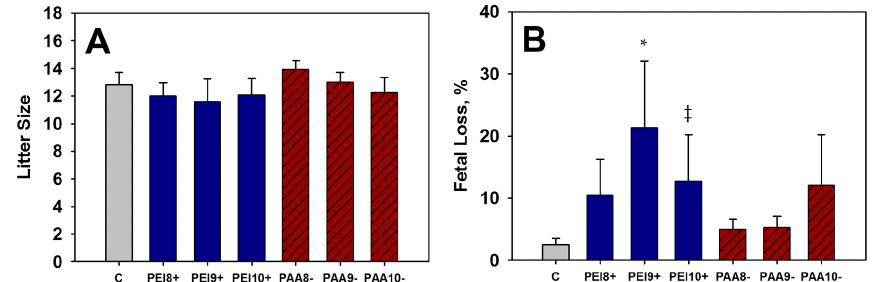
Figure 6. Litter size ( A ) and fetal loss ( B ) measured from matings of adult mice previously exposed to 100 mg/kg of iron oxide NPs in utero , and the control, C, on various days of gestation (GD 8, 9, or 10). * Significant difference between treatment group and the control ( p < 0.05). ‡ Trend between treatment and control at ( p < 0.1).